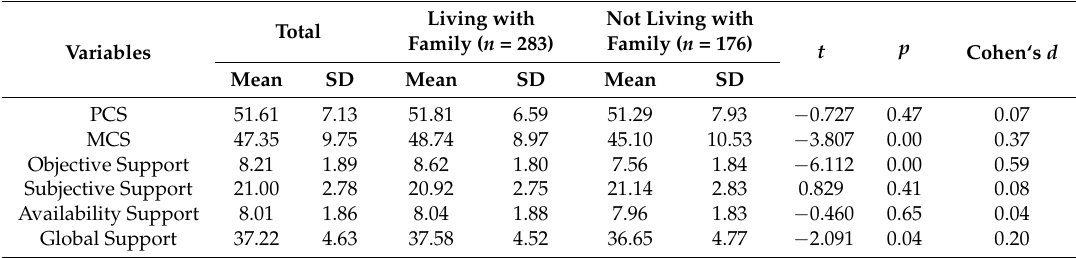
Table 3. Descriptive statistics for HRQoL variables, social support by living arrangements.